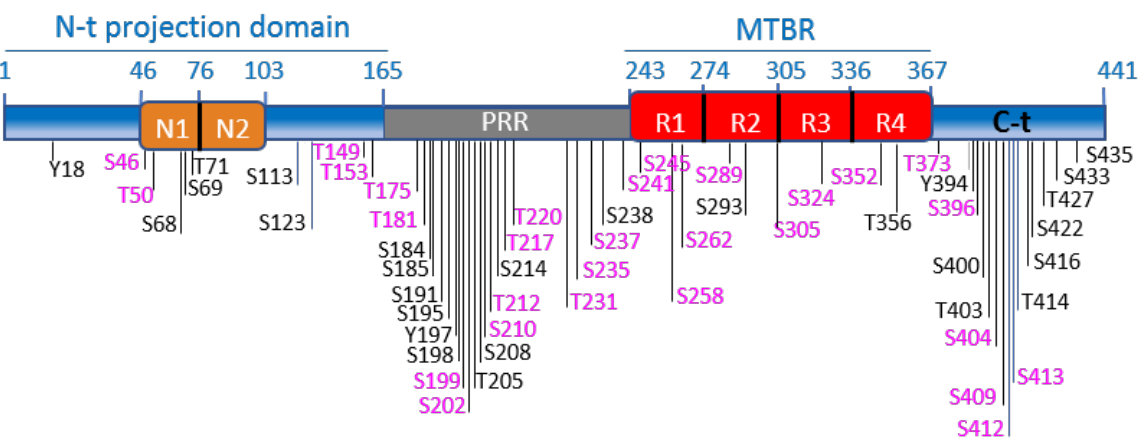
Figure 2. Tau functional domains and phosphorylation sites. Schematic illustration of tau functional domains and localization of the best characterized phosphorylation sites. GSK-3 phosphorylation sites are highlighted in fuchsia. The scheme illustrates the longest tau isoform (tau4R, 441aa). The N-terminal projection domain (aa1-165) contains two inserts, N1 (aa46-75) and N2 (aa76-102). The proline-rich region (PRR) (aa165-242) contains numerous phosphorylation sites, for GSK-3 and other kinases. Tau binds to MTs through the microtubule-binding region (MTBR), which comprises 4 imperfect repeats: R1 (aa243-273), R2 (aa274-304). R3 (aa305-335) and R4 (aa336-367). The C-terminal domain is formed by